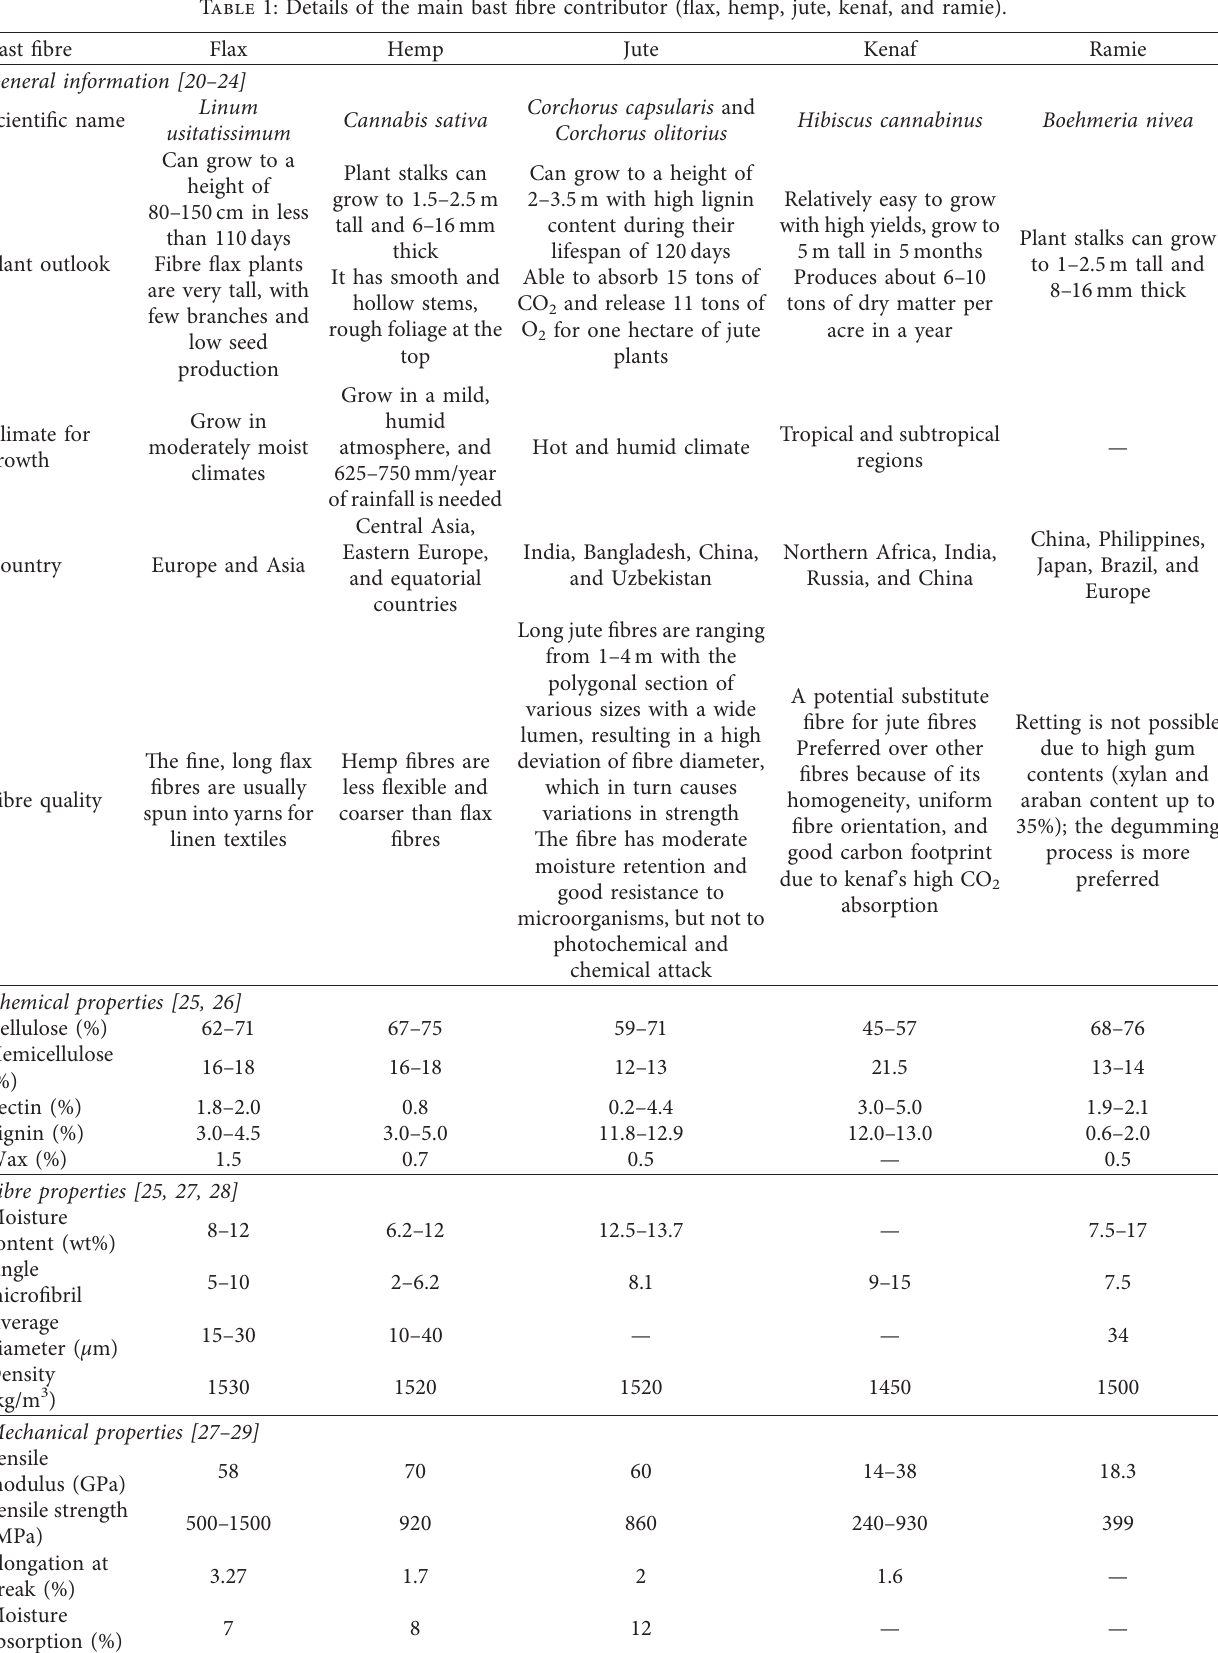
Table 1: Details of the main bast fibre contributor (flax, hemp, jute, kenaf, and